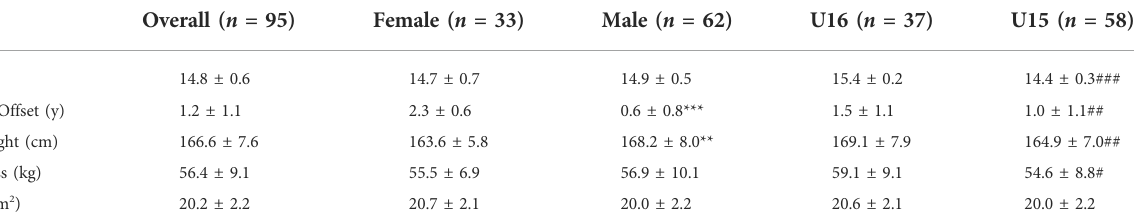
TABLE 1 Overview of the participants at